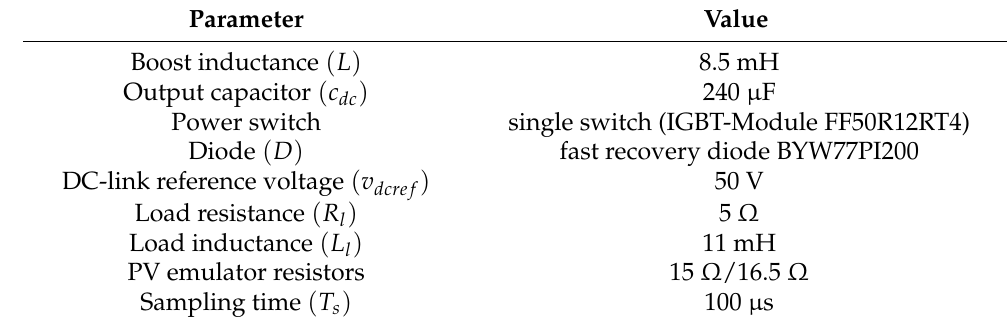
Table 2. PV system